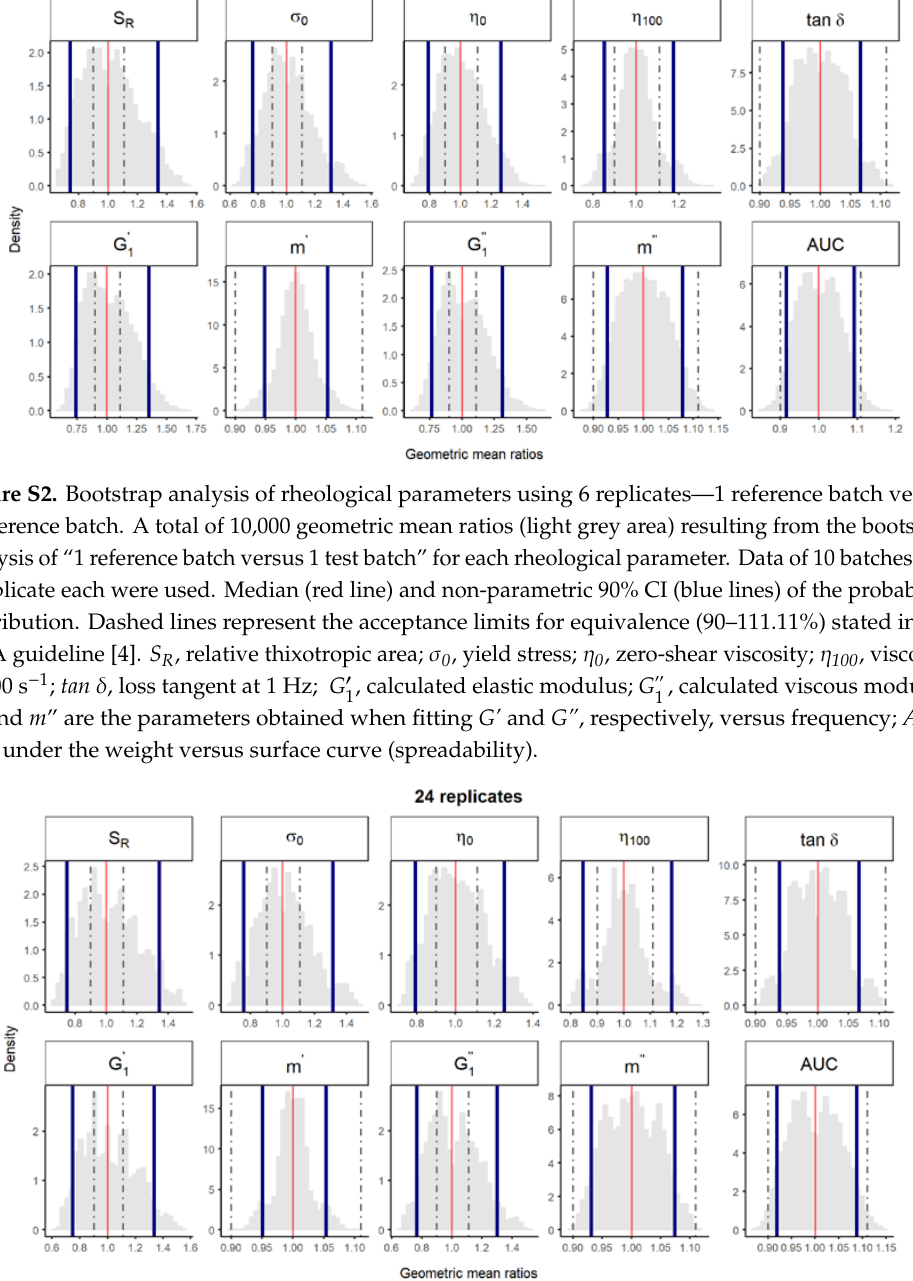
Figure S3. Bootstrap analysis of rheological parameters using 24 replicates—1 reference batch versus 1 reference batch. A total of 10,000 geometric mean ratios (light grey area) resulting from the bootstrap analysis of “1 reference batch versus 1 test batch” for each rheological parameter. Data of 10 batches and 24 replicate each were used. Median (red line) and non-parametric 90% CI (blue lines) of the probability distribution. Dashed lines represent the acceptance limits for equivalence (90%–111.11%) stated in the EMA guideline [4]. S R , relative thixotropic area; σ 0 , yield stress; η 0 , zero-shear viscosity; η 100 , viscosity at 100 s −1 ; tan δ , loss tangent at 1 Hz; , calculated elastic modulus; , calculated viscous modulus; m' and m" are the parameters obtained when fitting G' and G'' , respectively, versus frequency; AUC , area under the weight versus surface curve (spreadability).